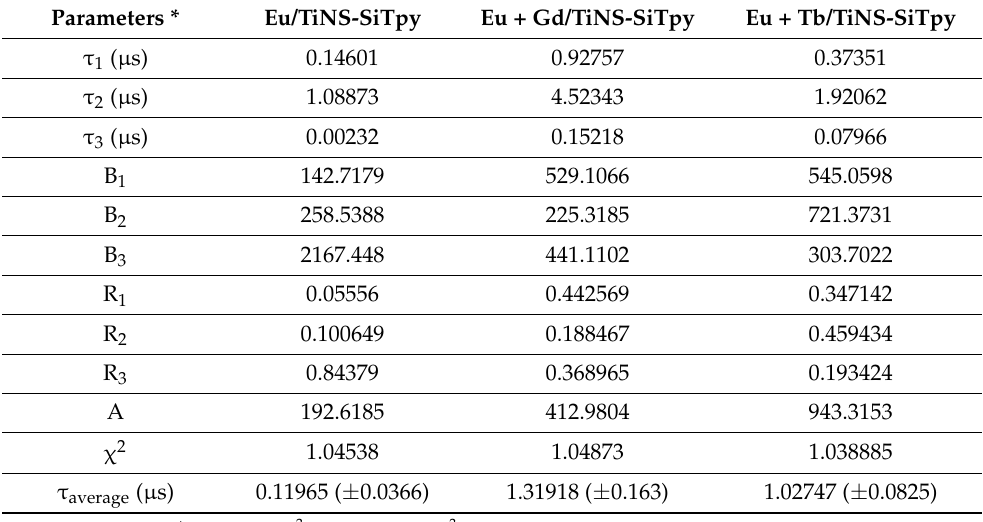
Figure 8. PL (photoluminescence) decay curves at 610 nm emission line at an excitation wavelength of 374 nm for electrodeposited Eu (red dots), Eu + Gd (pink dots), and Eu + Tb (green dots). Table 2. Fitting parameters of the PL (photoluminescence) decay curves in Figure 8 for electrode- posited Eu, Eu + Gd, and Eu + Tb on TiNS-SiTpy